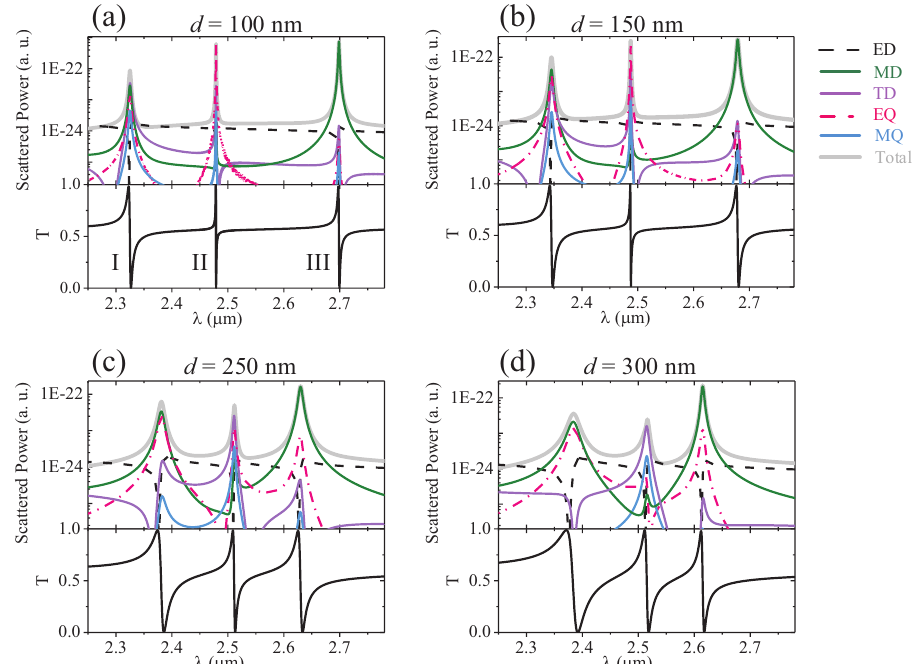
Figure 5. Total scattered power and contributions of different multipoles under different air-hole radii r .